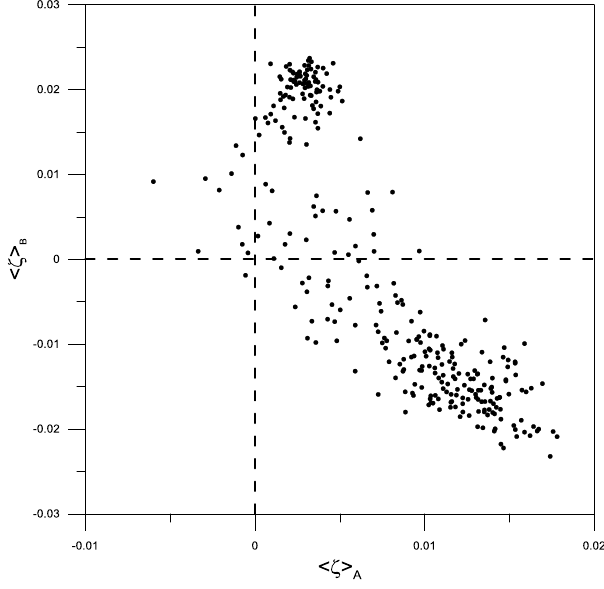
Fig. 11. Scatter plot of ˜h ζ i averaged in sectors A and B.